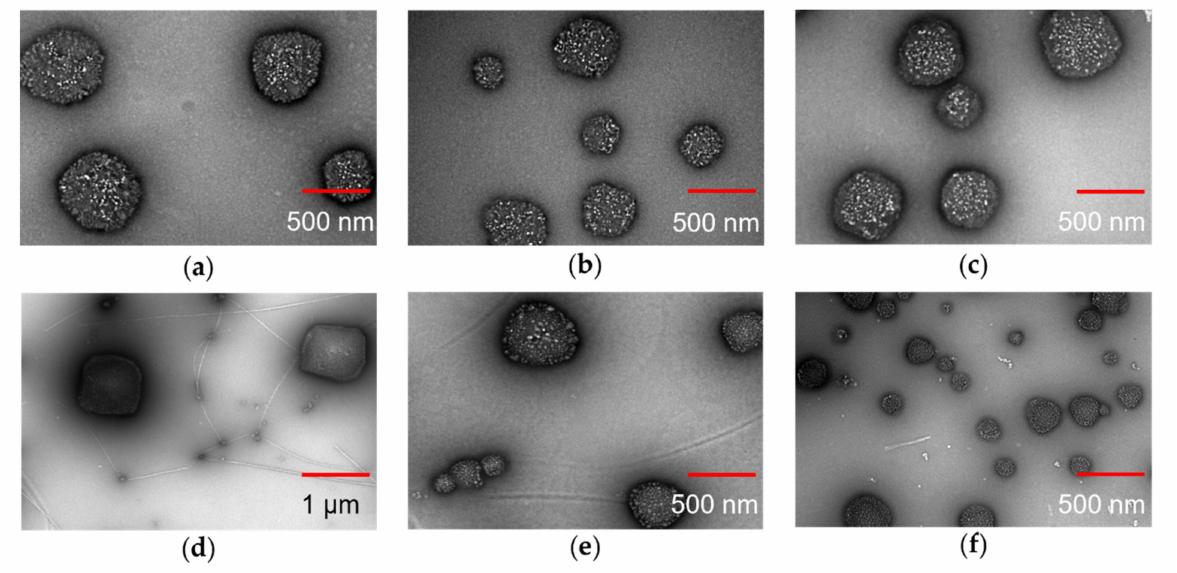
Figure 3. TEM images of assembled nanogels. ( a ) HA-pNIPAM 0.1, ( b ) HA-pNIPAM 0.15, ( c ) HA-pNIPAM 0.25, ( d ) AA- HA-pNIPAM 0.1 (4 ◦ C), ( e ) AA-HA-pNIPAM 0.15 (4 ◦ C) and ( f ) AA-HA-pNIPAM 0.25 (4 ◦ C). Scale bars indicate 500 nm except 1 µ m for ( d ). Table 1. The comparison of particle sizes of the nanogels using DLS and NTA at 25 ◦ C (mean ± SD, n = 3).